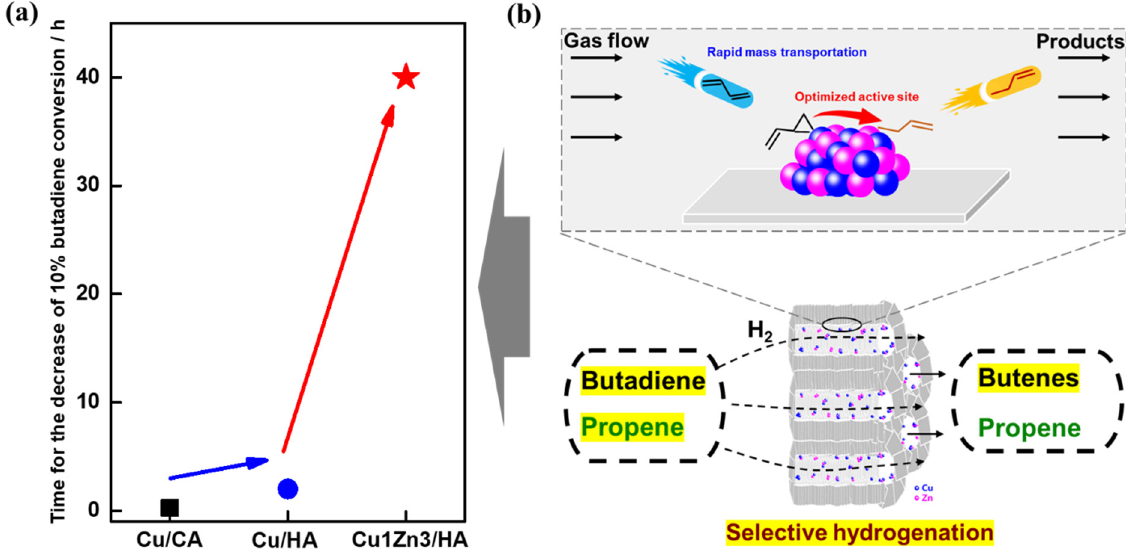
Figure 6. Evolution of the time needed to reach a 10% butadiene conversion decrease with different structures and compositions of samples ( a ) and a scheme of the synergistic effect of porous hierarchy and alloying in a catalytic reaction ( b ).